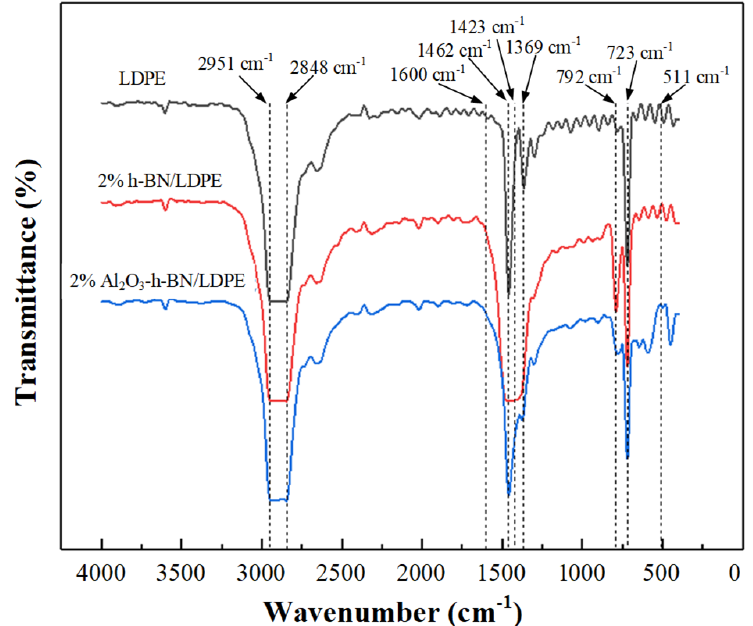
Figure 3. The infrared-light spectrum of pure LDPE and its nanocomposite films.